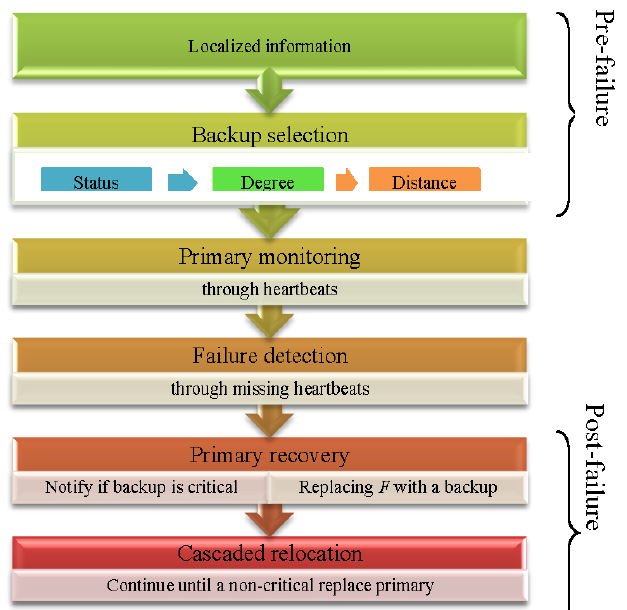
Figure 3. Overview of the PCR